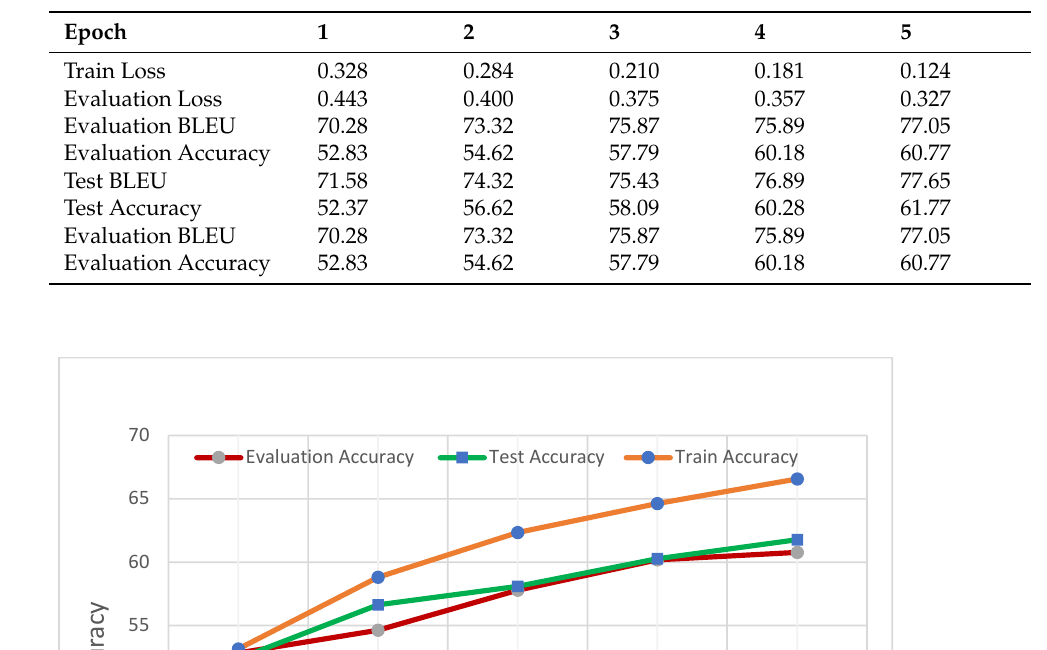
Table 6. The performance of BART large using SPoC dataset and 5 epochs.